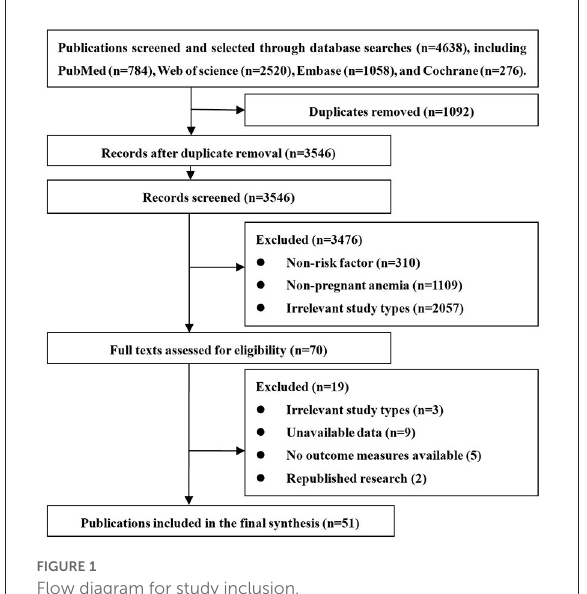
FIGURE1 Flow diagram for study